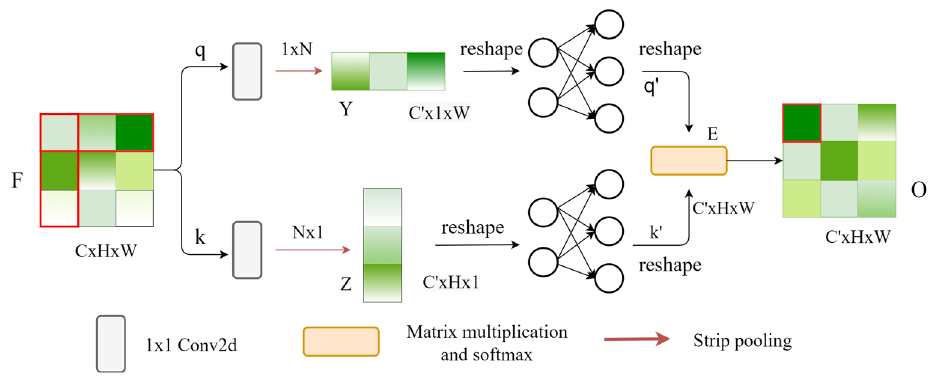
Figure 2. The main architecture of the FF